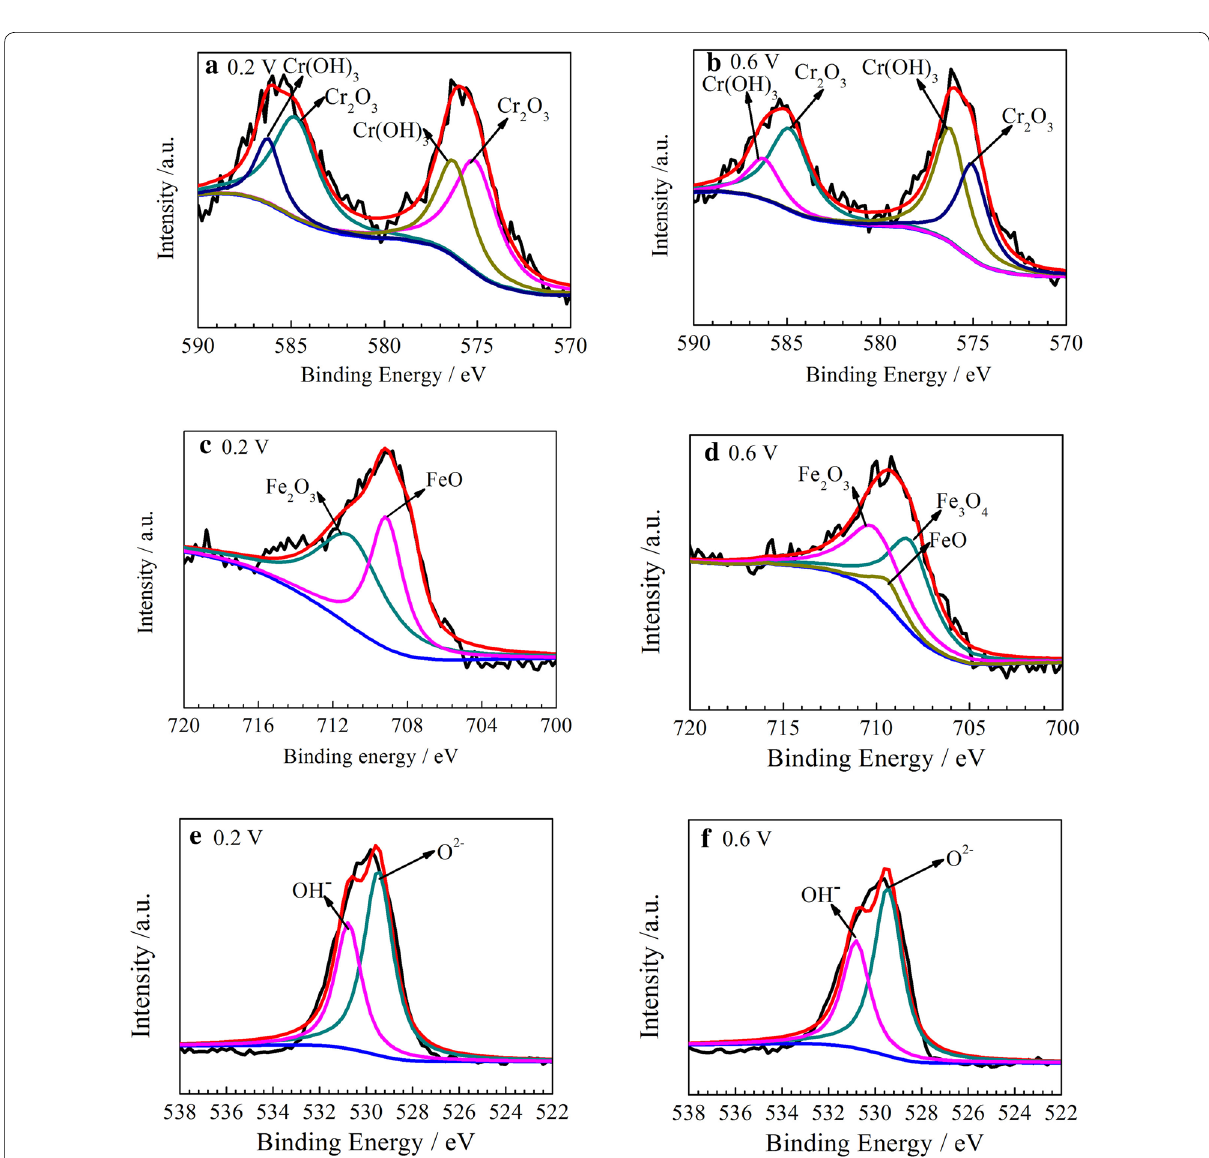
Figure 8 The detailed XPS spectra of ( a , b ) Cr 2p 3/2 , ( c , d ) Fe 2p and ( e , f ) O1s of the passive films formed on 304 stainless steels oxidized for 1 h in borate buffer